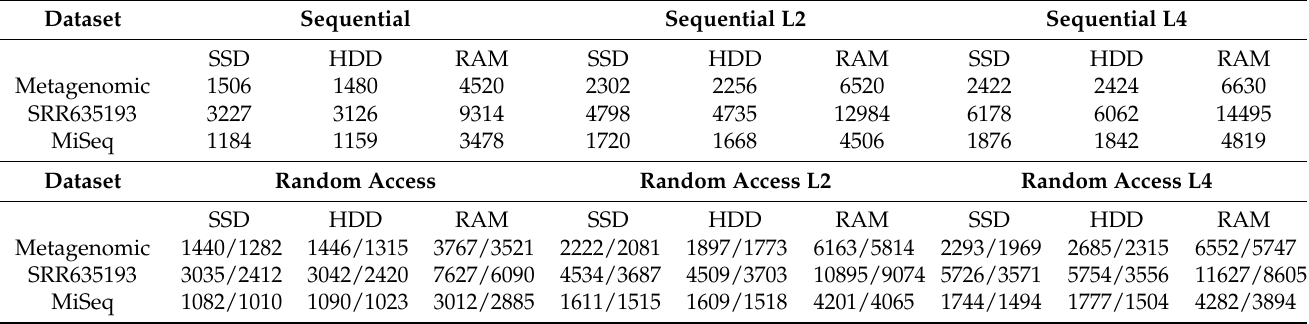
Table 3. Access speed measured in single end records per second. The two results for random access are for (random contiguous blocks)/(random individual